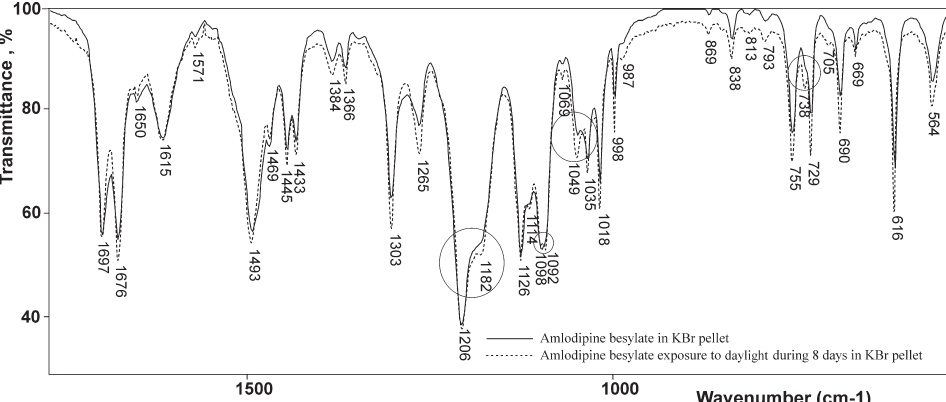
Figure 6b. FTIR spectrum of amlodipine besylate without and with irradiation with daylight during 8 days (range 500 - 1800 cm -1